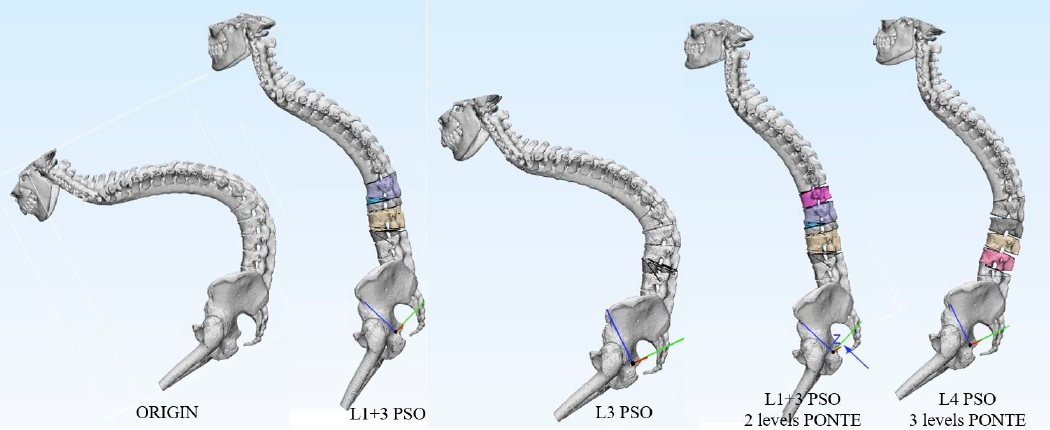
Figure 3. Simulation and comparation of different surgical plans.